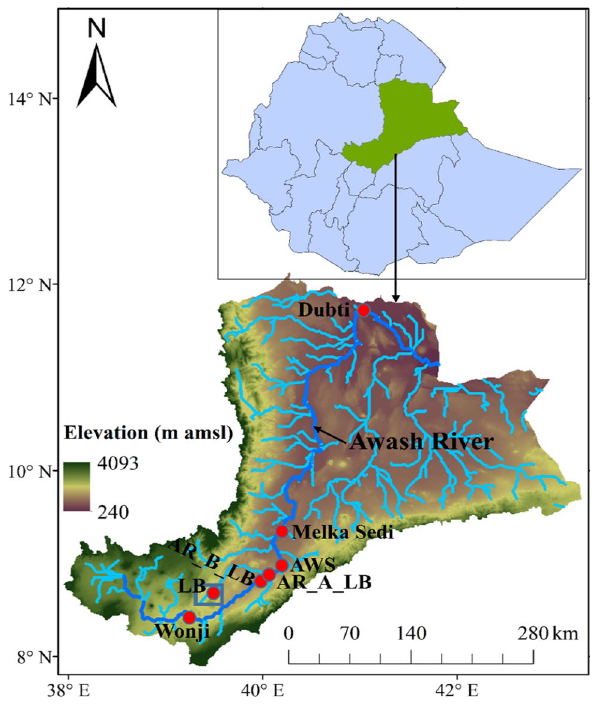
Fig. 1 Location of the study area and sampling sites